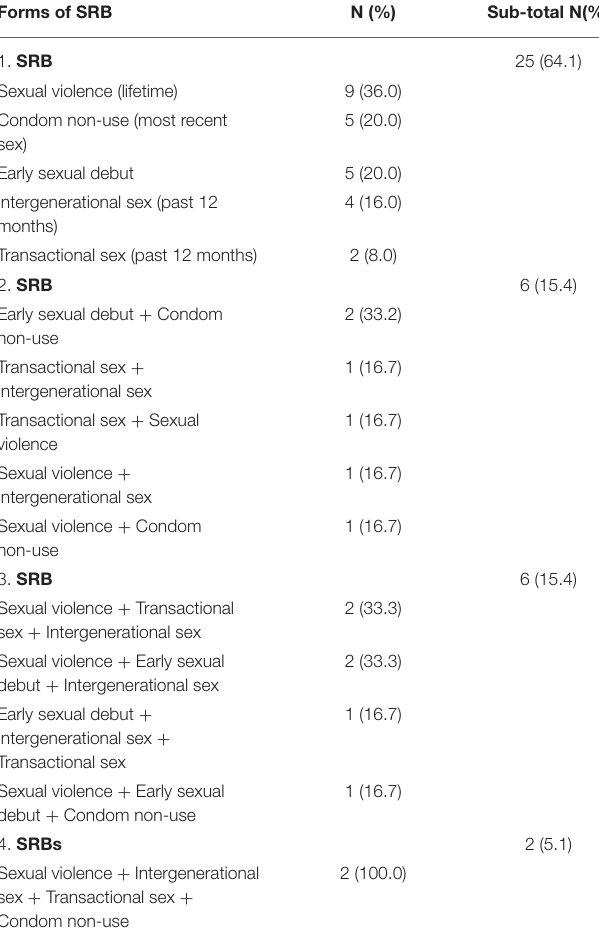
TABLE 3 | Results from multivariate logistic regression showing factors associated with the experience of the adolescents of sexual risk behavior ( N = 292).